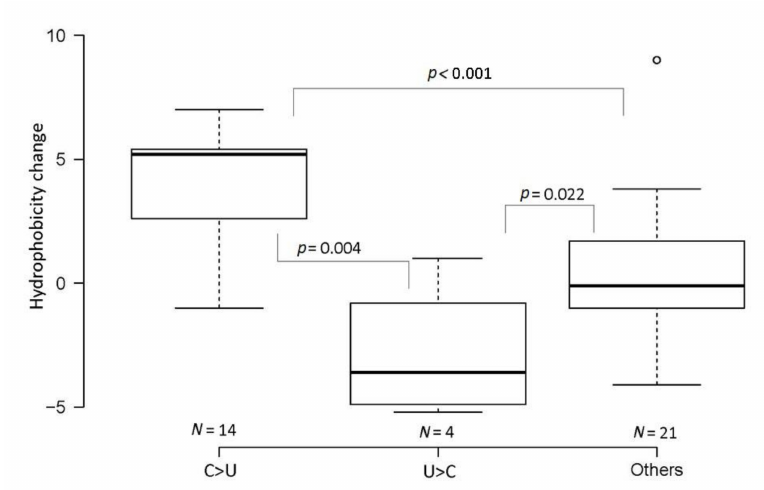
Figure 3. Changes in the hydrophobic properties of amino acids in nonsynonymous substitutions. The Y axis represents shifts in hydrophobicity values between replaced amino acids. The data were obtained from single-nucleotide variations (SNVs) in the SARS-CoV-2 sequences (Table